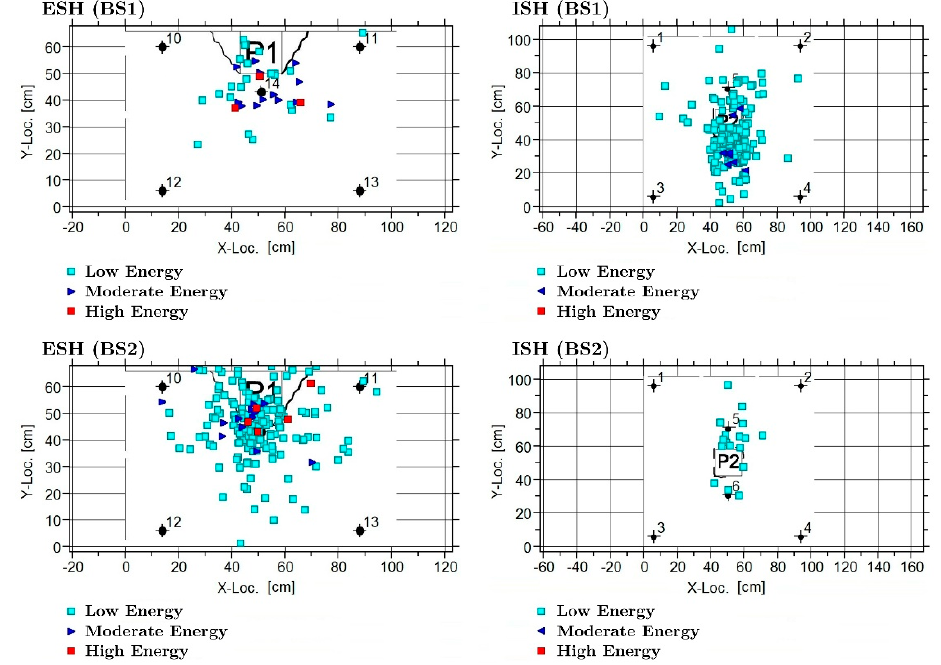
Figure 10. Planar location of the AE events at ESH and ISH zones for specimens BS1 and BS2. 276